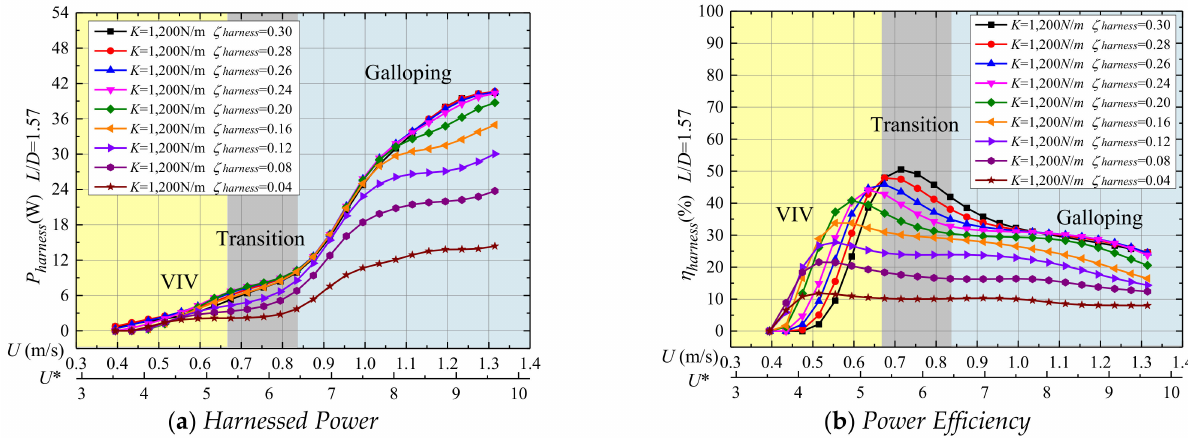
Figure 9. ( a ) Harnessed power and ( b ) power efficiency of two tandem cylinders with spacing ratio L / D = 1.57; K = 1200 N/m; ζ harness =